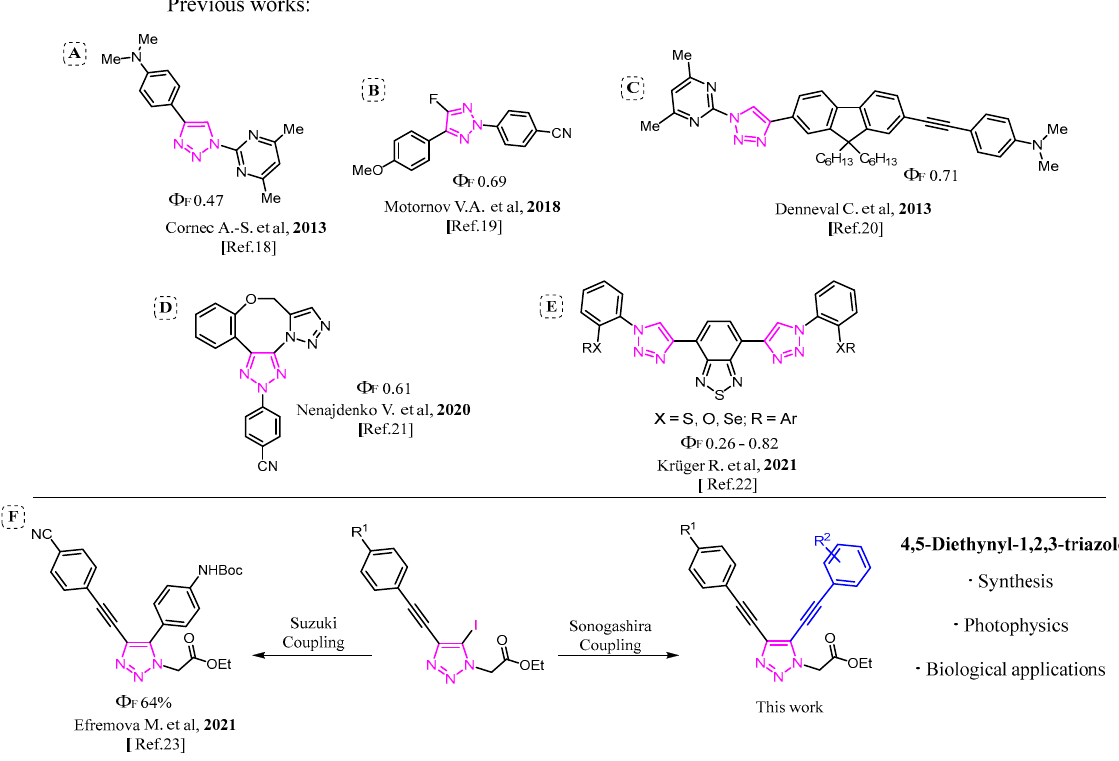
Figure 1. Known push–pull fluorescent 1,2,3-triazoles ( A – F ) and the target structure of the current